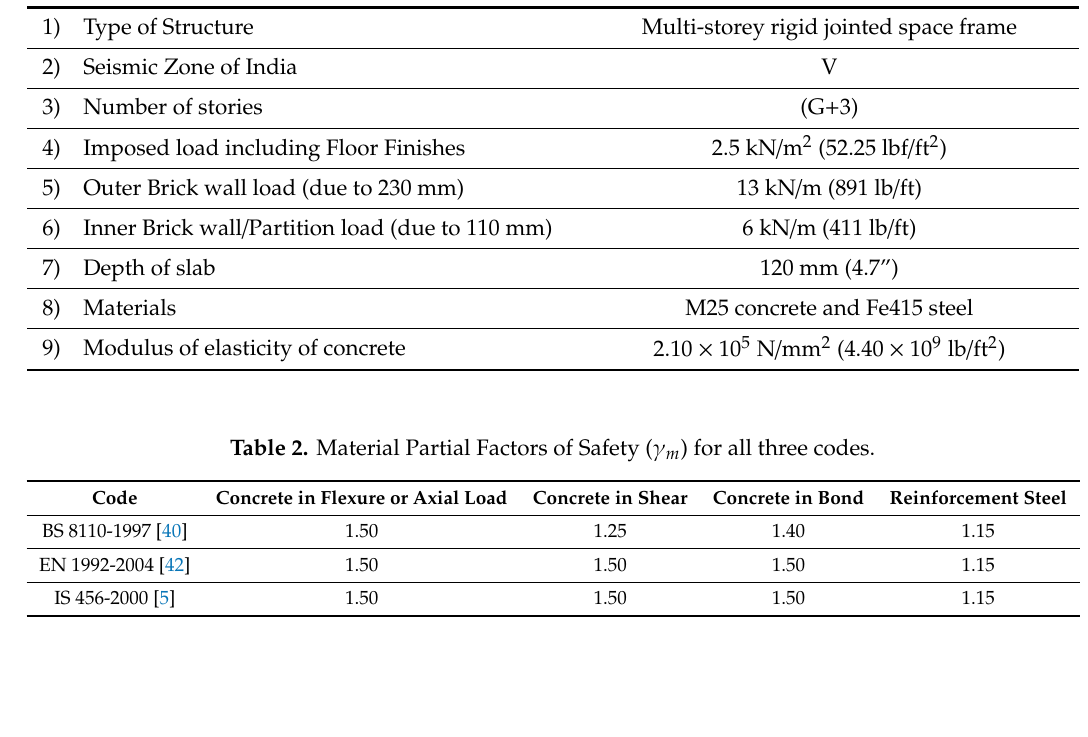
Figure 1. Typical building plan. Table 1. Preliminary data for G + 3 space frame.